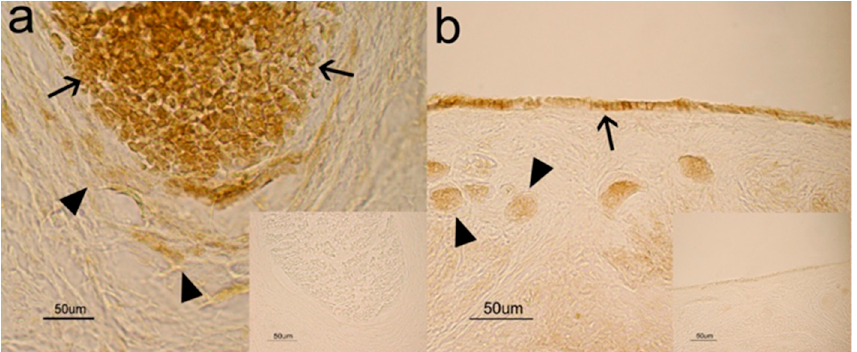
Figure 2. Nerve growth factor receptor (NGFR) ( a ) and neurotrophic tyrosine kinase receptor 1 (NTRK1) ( b ) IR in the ovaries of grey squirrels. In both cases, the positive reaction is localized in the cytoplasm of thecal (arrowheads) and granulose (arrows) cells ( a ) and in germinative epithelium (arrow) and follicular cells (arrowheads). Bar = 50 µm.